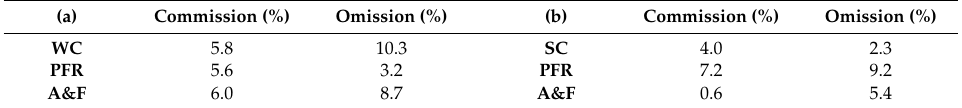
Table 5. Commission and omission errors, expressed as percentage, for the contingency matrices of the global evaluation (Grouping the data of all Rio de la Plata Grasslands (RPG) sub-regions and all the agricultural years. (a) Winter campaign, (b) Summer